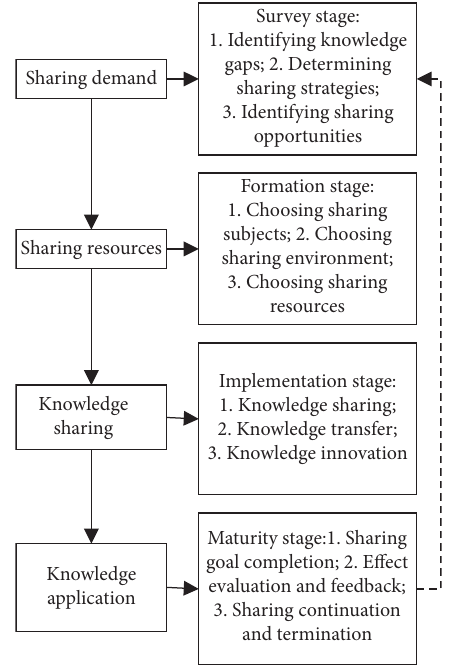
Figure 3: Procedure of knowledge sharing service.